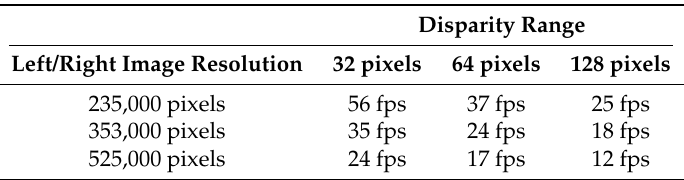
Table 4. Processing speeds vs. left/right image